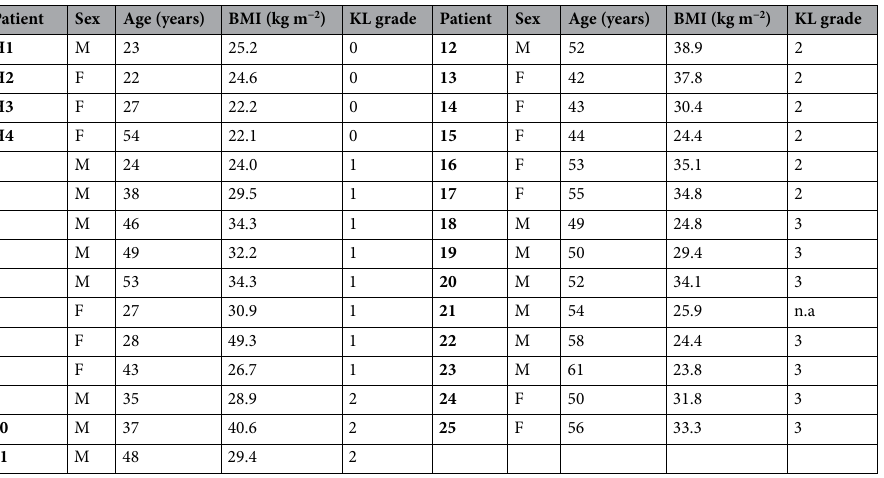
Table 1. Patient demographics and radiographic data. H healthy donor, M male, F female, BMI body mass index, KL Kellgren and Lawrence system of knee OA classification, n.a. not available.